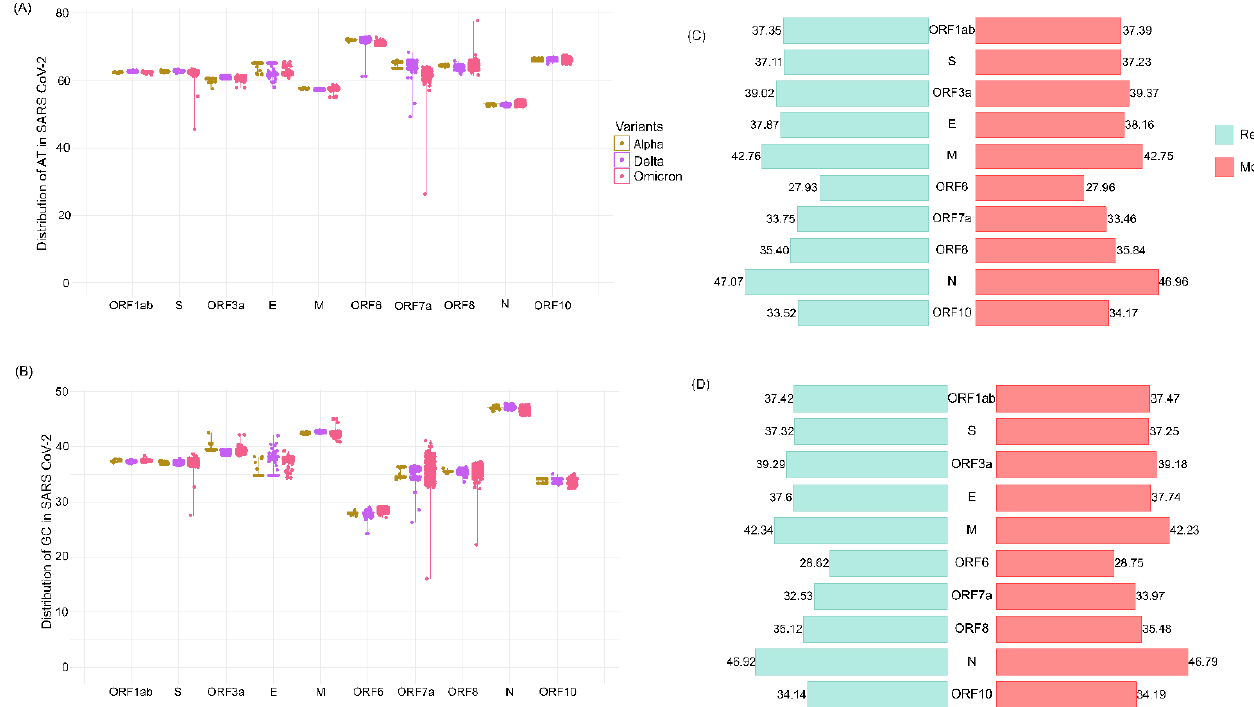
Figure 2. Dinucleotide distribution across the genomic regions of lineage- and clinical-outcome- based sub-groups. ( A ) AT/U percentage across distinct sub-genomic regions of Alpha, Delta, and Omicron. ( B ) GC percentage across different sub-genomic regions of Alpha, Delta, and Omicron. ( C ) Average GC distribution in the clinical outcome groups of Delta – Recovered and Mortality. (D) Average GC distribution in the clinical outcome group of Omicron – Recovered and Mortality.